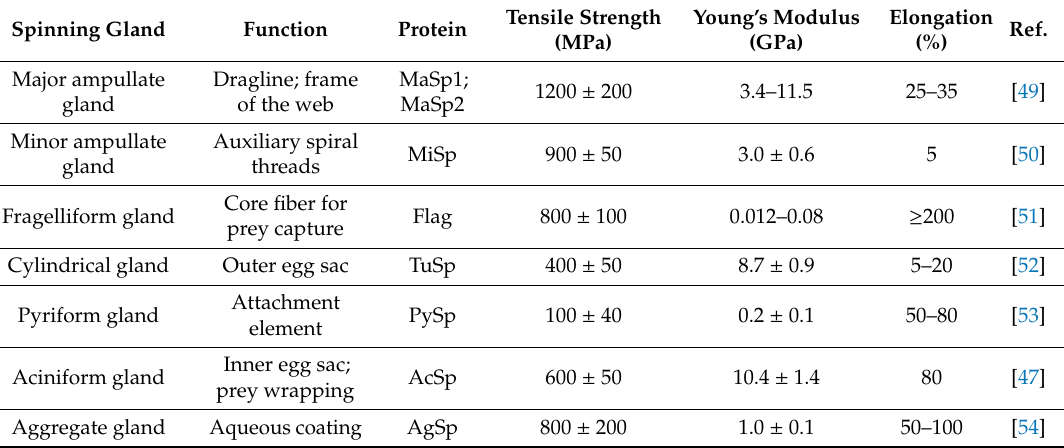
Table 1. Mechanical properties of natural spider silk fibers